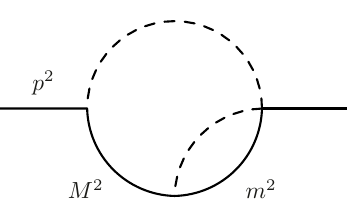
Figure 4 . The diagram for sector 1, namely I ( M 2 ; m 2 ; 0 ; 0 ; p 2 ). The dashed lines denote massless